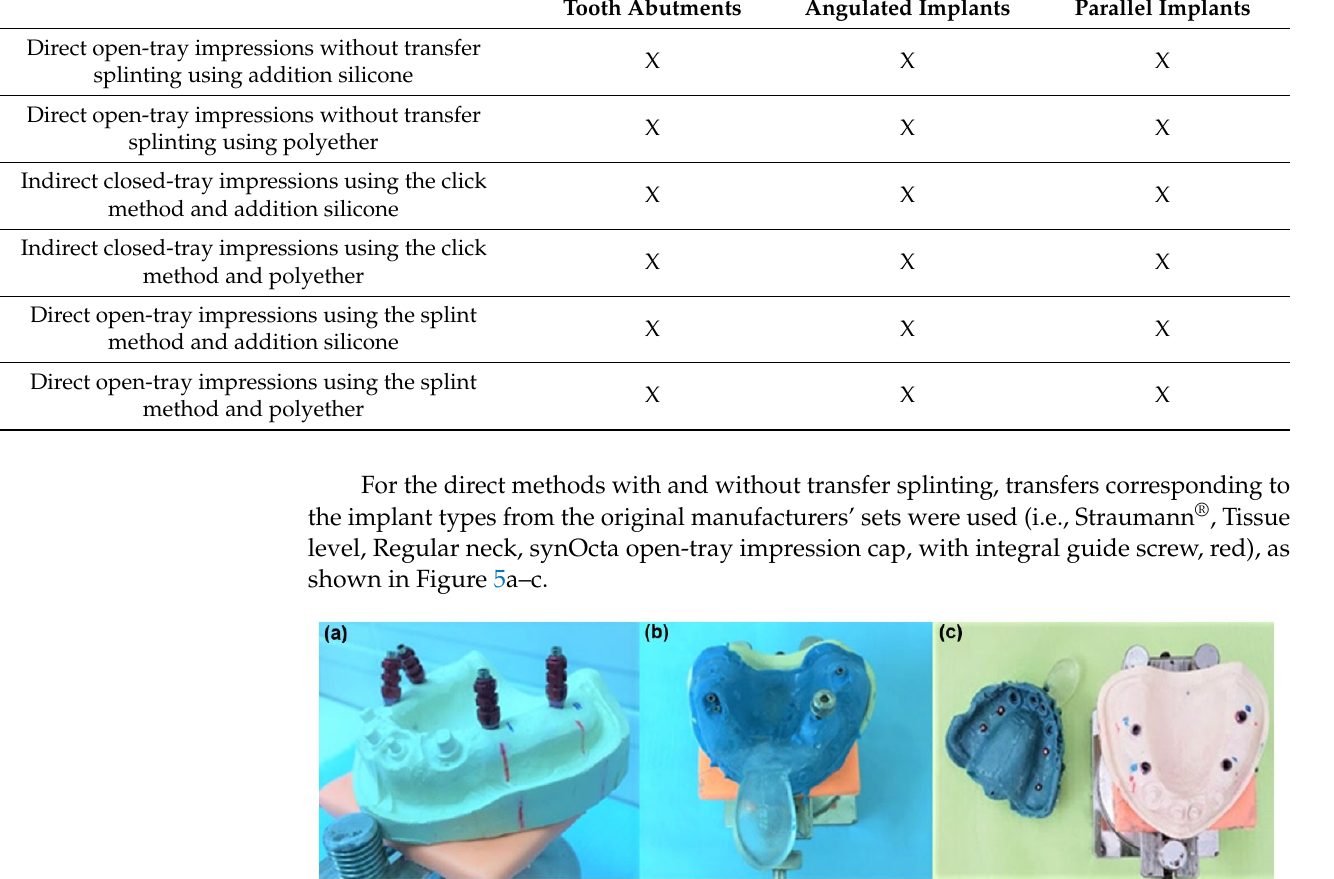
Table 1. The experimental group characteristics and the experimental plan for the three main control groups. Tooth Abutments Angulated Implants Parallel Implants